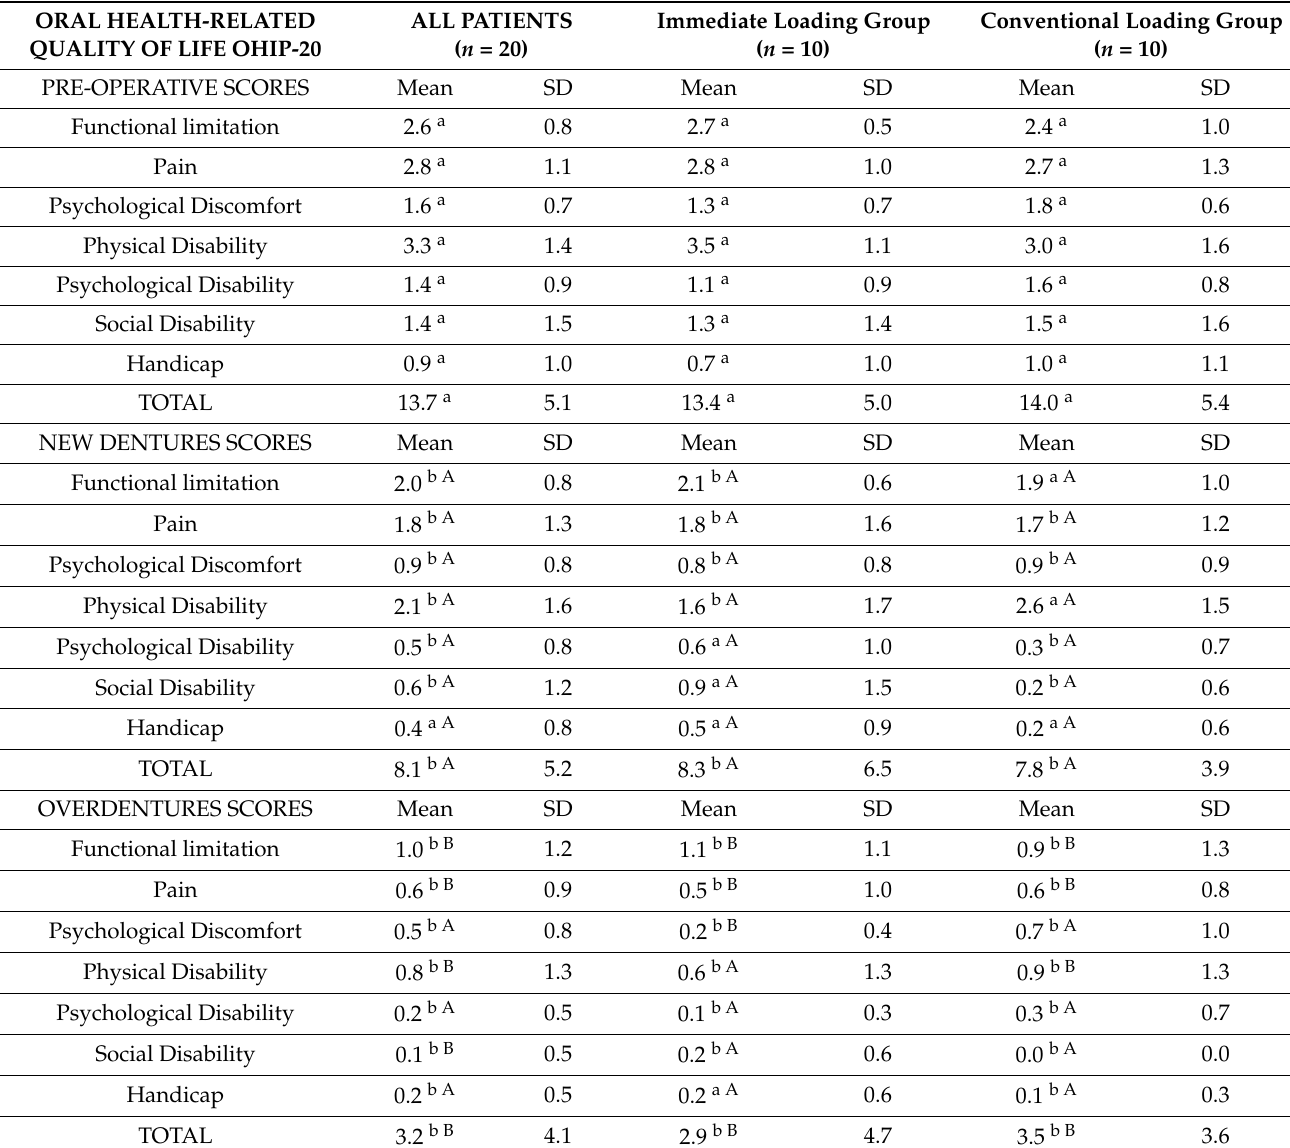
Table 8. Changes in oral health-related quality of life (OHIP-20), by simple count method ϕ after sequential prosthetic treatments, i.e., new dentures and overdentures ( n =